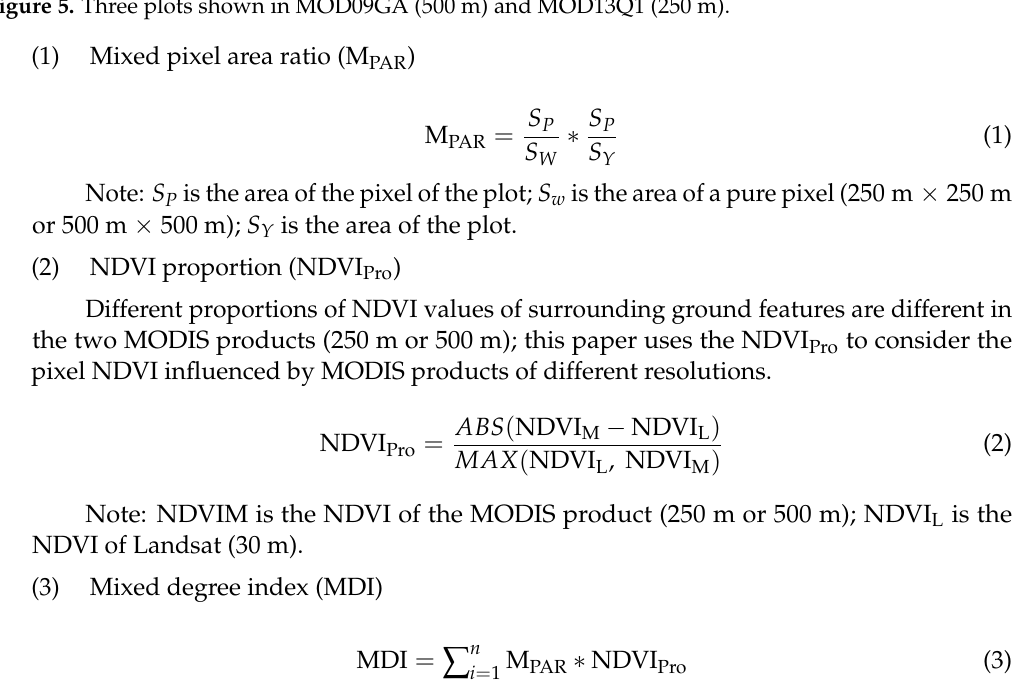
Figure 6. Three plots shown on the Sheely Farm crop